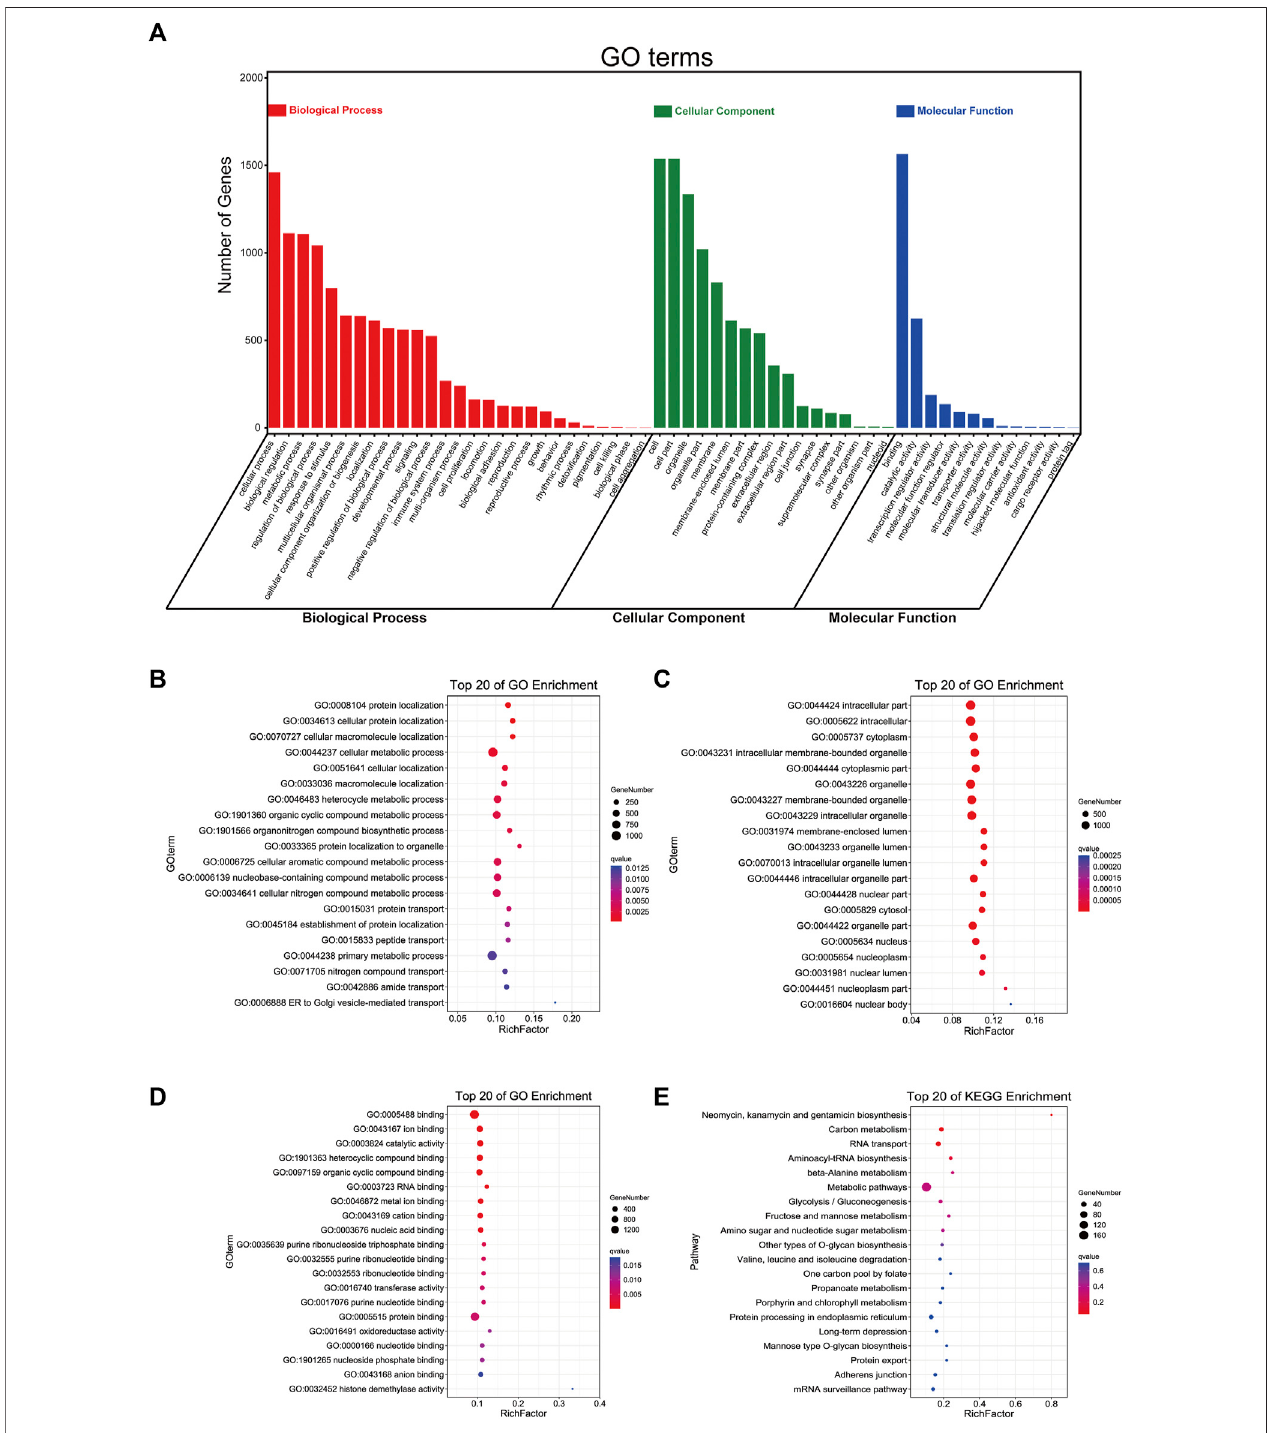
FIGURE5| Functional enrichmentanalysisof17m5C-relatedlncRNAs with prognostic value. (A) Thesummary bar plotofGOenrichments. (B – D) Therespective top 20 GO enrichments of biological process, cellular component, and molecular function. (E) The top 20 KEGG pathways.